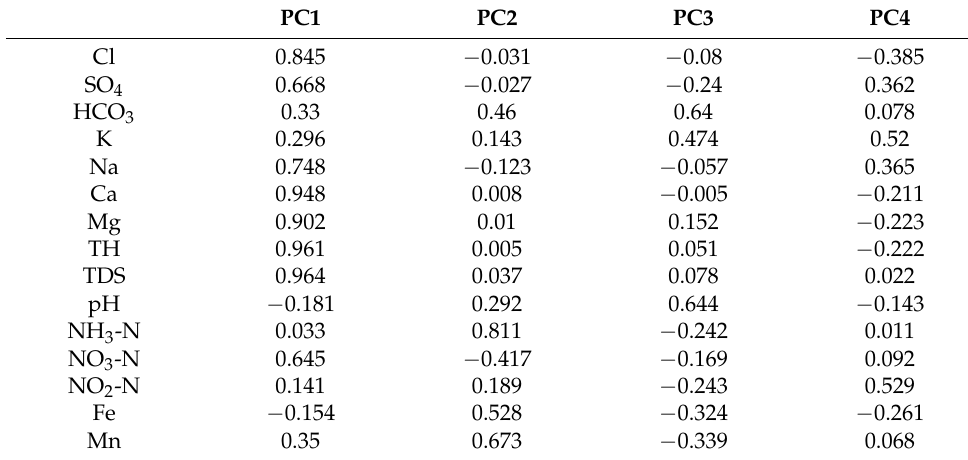
Table 3. Element matrix of